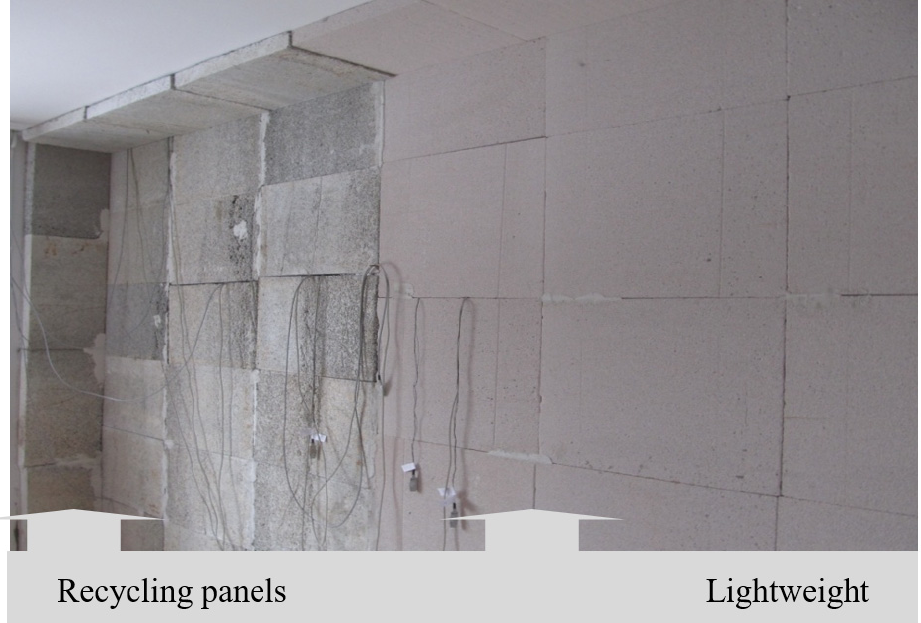
Figure 8. Diagram of the assembly of the test stand.